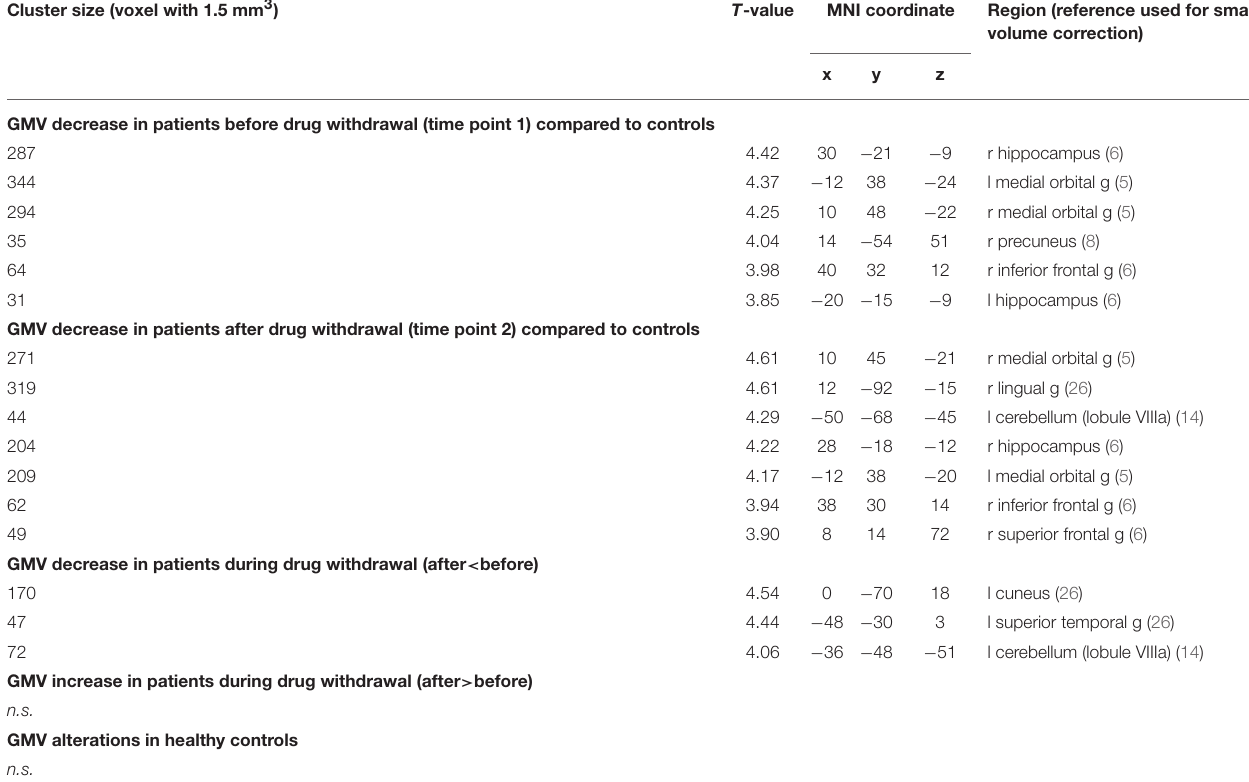
TABLE 2 | Gray matter volume (GMV) alterations of MOH patients by means of voxel based morphometry (VBM) analysis. Cluster size (voxel with 1.5 mm 3 ) T -value MNI coordinate Region (reference used for small